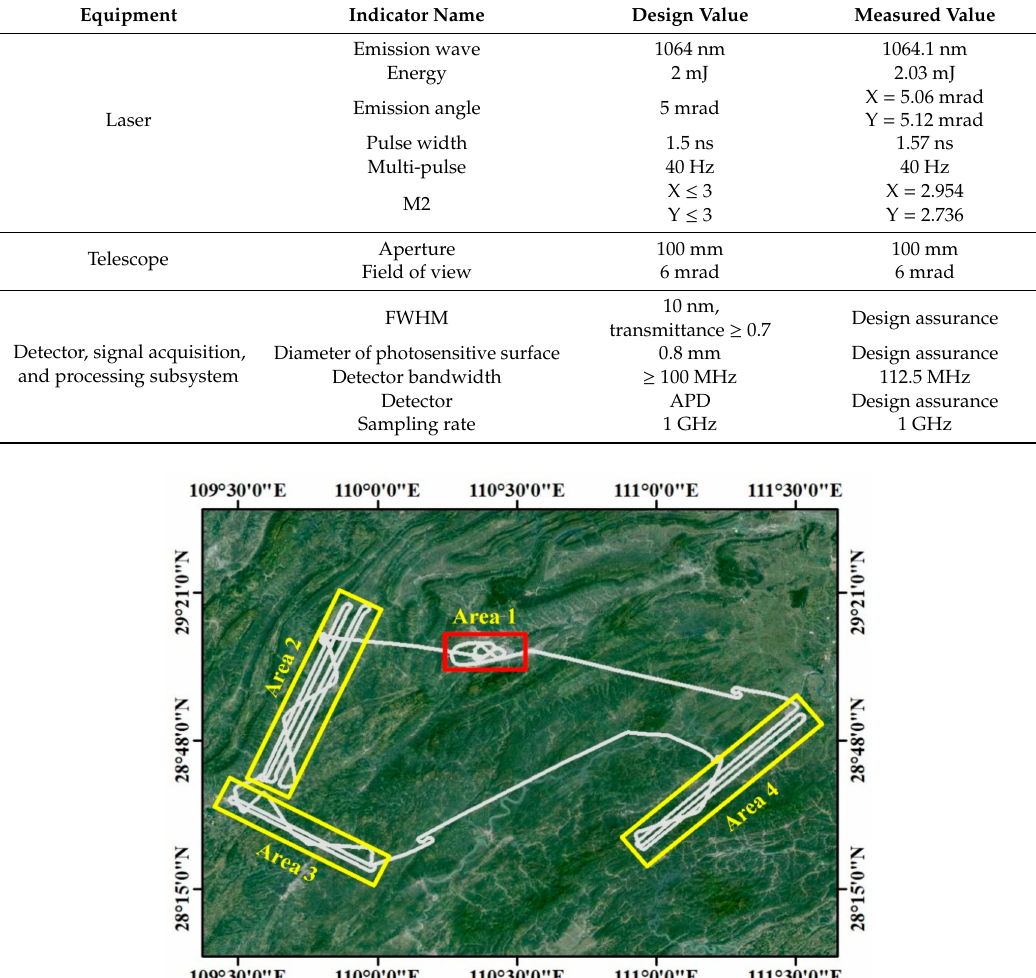
Table 1. Technical parameters for airborne large-footprint lidar used in this study.